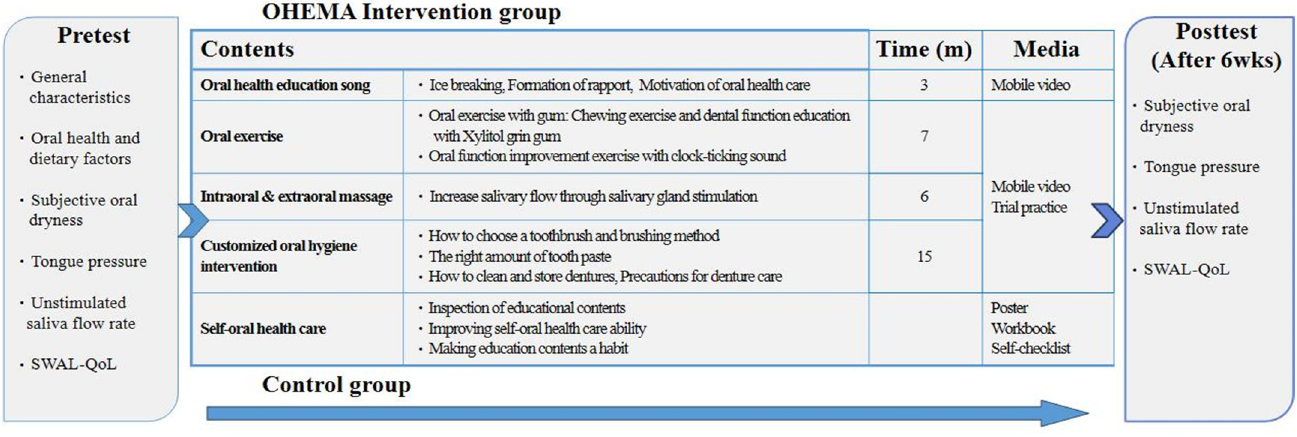
Figure 2. Flowchart of oral health education intervention using mobile app (OHEMA).